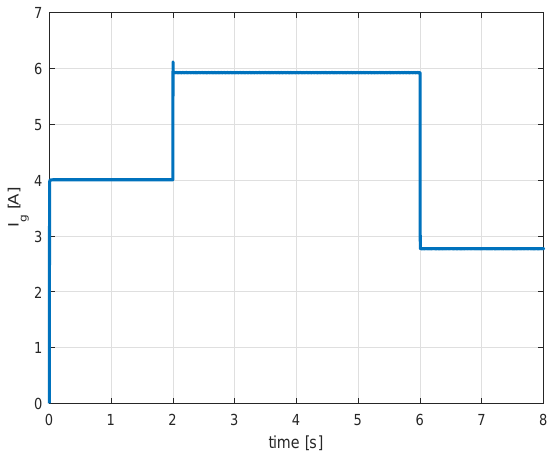
Figure 14. Detailed Simulation with PowerSystems: Generator current.